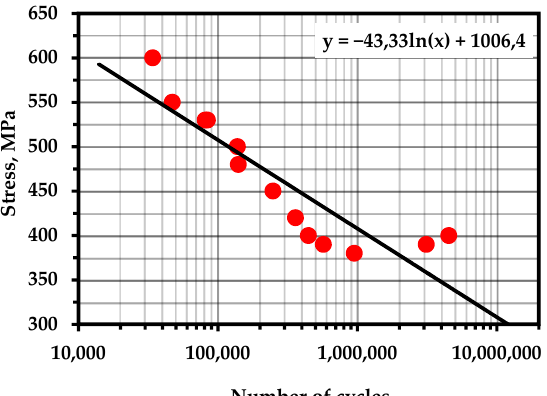
Figure A13. S–N Curve—Steel AISI 316LN (Temperature—293 K; frequency—10 Hz; R = 0.1) [106].